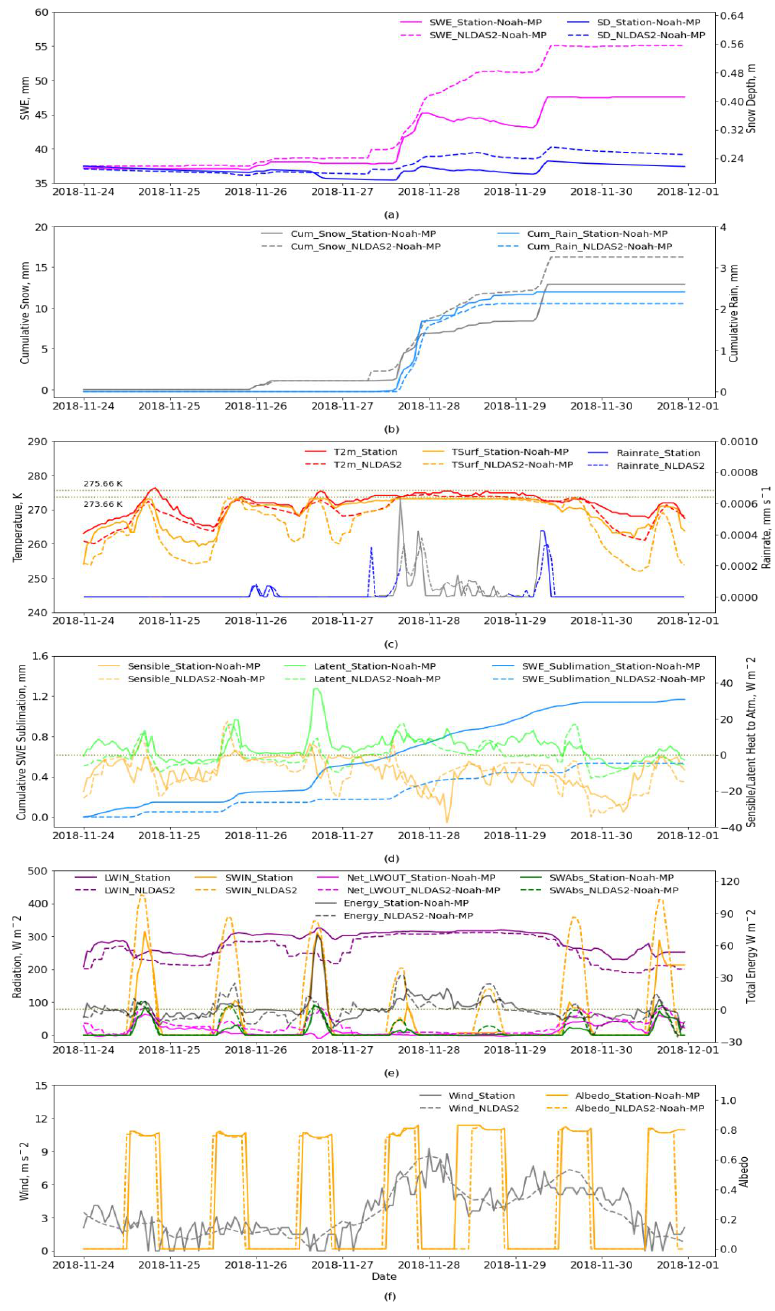
Figure 5. ( a ) Snow Water Equivalent and Snow Depth; ( b ) Cumulative Snow and Rain; ( c ) 2 m air Temperature (T2m), Surface Radiative Temperature (TRAD), and Rain-rate (gray color indicating mixed precipitation and blue color indicating snowfall); ( d ) Sensible and Latent Heat to the Atmosphere and Cumulative Snow/Ice Sublimation; ( e ) Incoming Longwave and Shortwave Radiation, Absorbed Shortwave Radiation, Total Net Outgoing Longwave Radiation, and Total Energy; and ( f ) Surface Albedo and Wind Speed, from 24 − 30 November 2018.